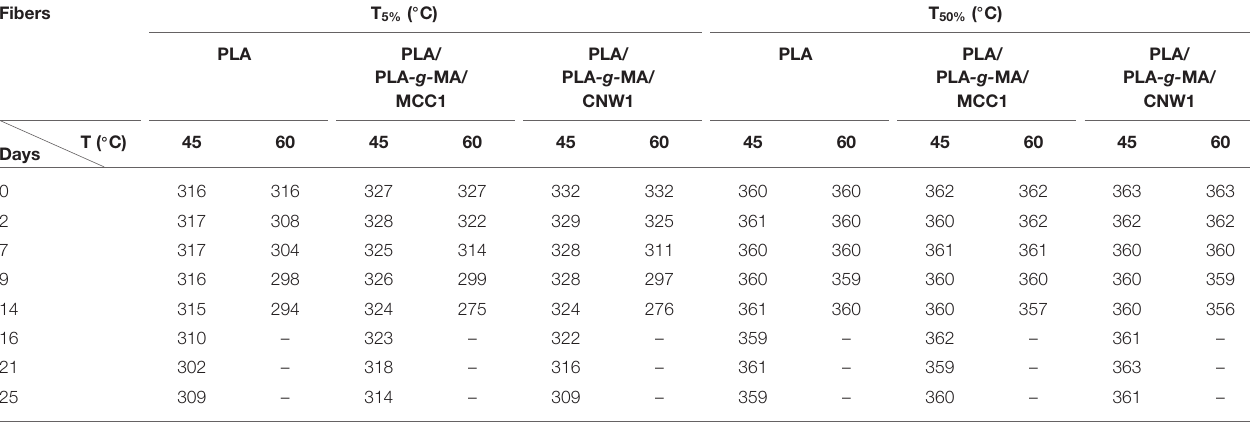
TABLE 5 | TGA data (T 5 % and T 50 % ) of PLA, PLA/PLA -g- MA/MCC1, and PLA/PLA -g- MA/CNW1 fibers recorded at 45 and 60 ◦ C in hygrothermal conditions.